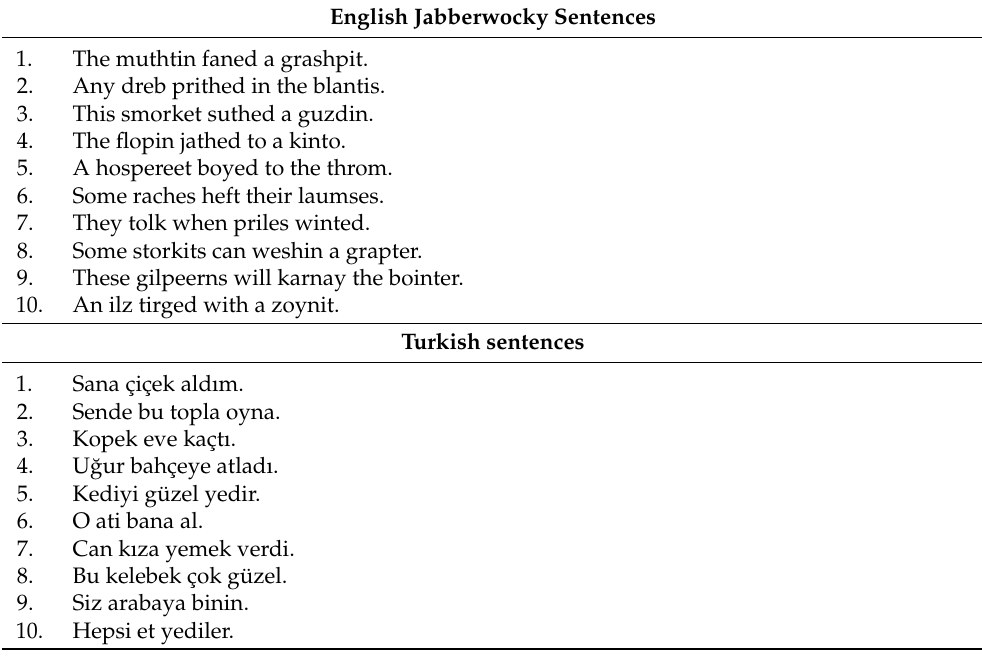
Table A1. English nonsense sentences and Turkish sentences used in the repetition task.